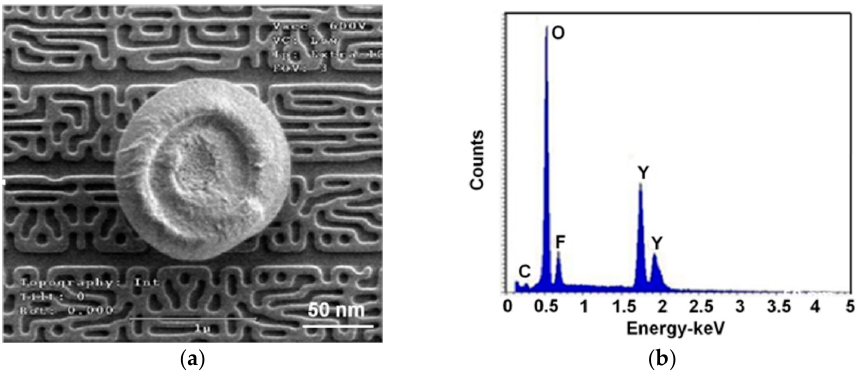
Figure 8. ( a ) SEM image of a circular particle and ( b ) energy dispersive X-ray diffraction (EDX) analysis results of circular particle.